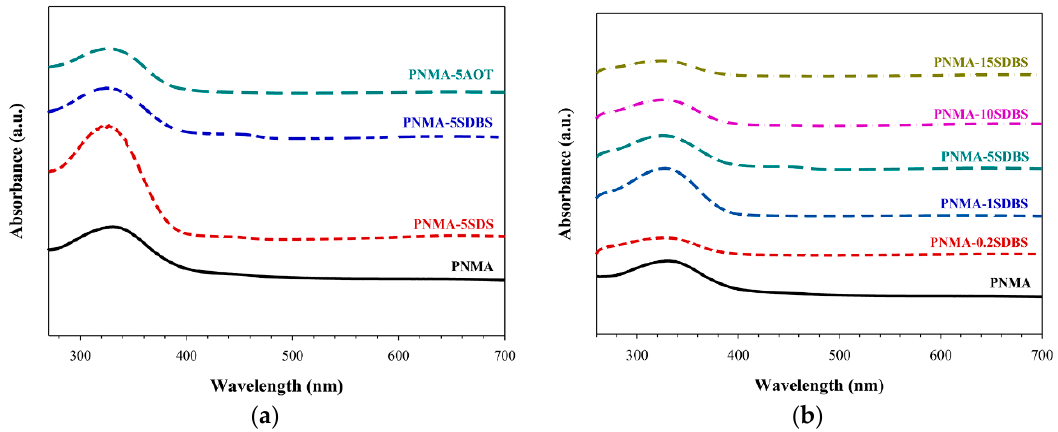
Figure 1. UV spectra of PNMA synthesized under different conditions: ( a ) different anionic surfactants, namely SDS, SDBS, and AOT; and ( b ) at various SDBS concentrations; in DMSO solution.